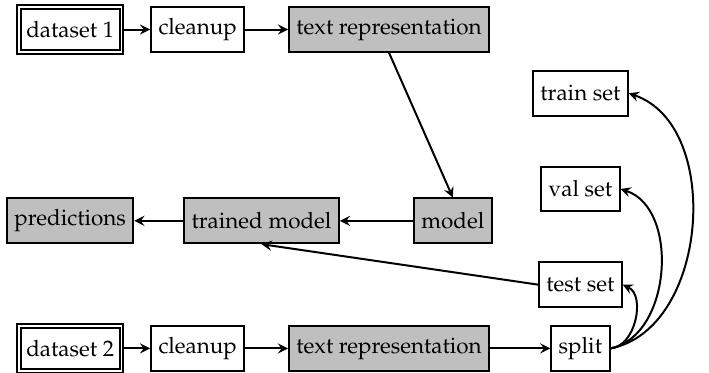
Figure 2. Classification pipeline for the cross-lingual and cross-domain